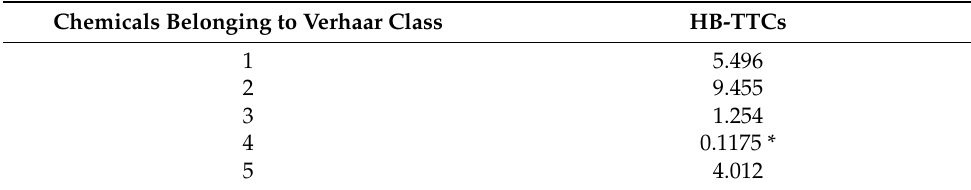
Table 3. The Human-Biota (HB)-TTCs. Values are ng/L. * indicates that the HB-TTC is derived from logistic fitted